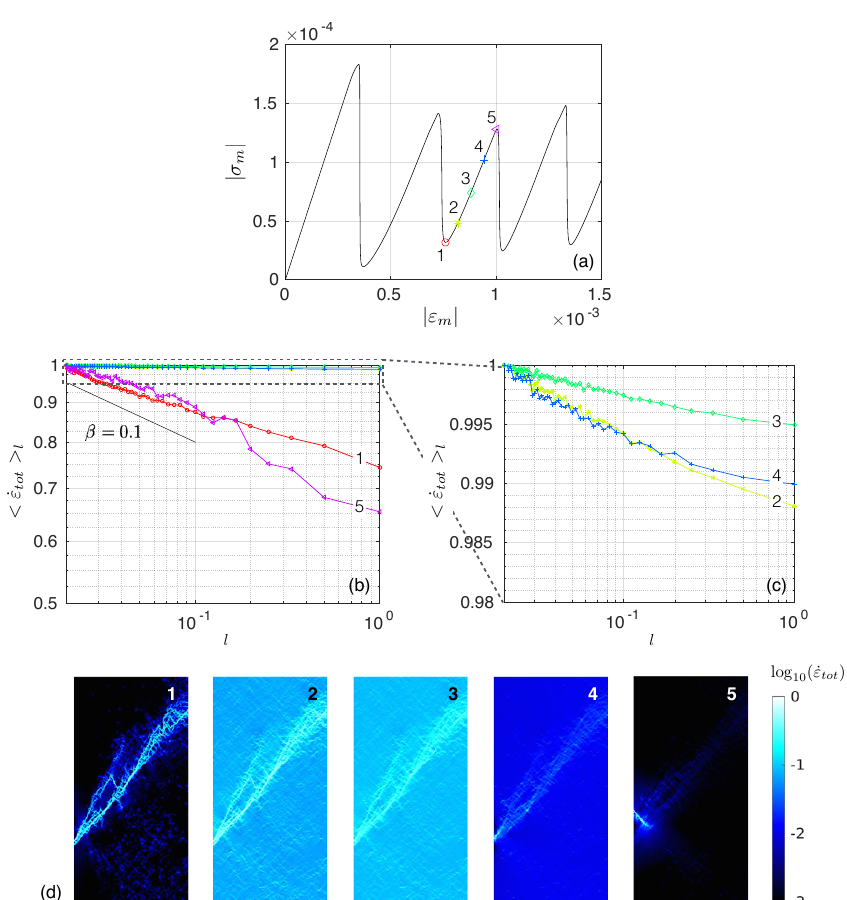
Figure 7. (a) Macroscopic stress as a function of the macroscopic strain for one realization of the uniaxial compression experiment with N = 100. (b) Total deformation rate as a function of the spatial scale ( l = L with 1 ≤ n ≤ N/ 2), normalized at the smallest scale L/N , 2 n at the five stages indicated on (a) . (c) Zoom into panel (b) for the second, third and fourth stages. (d) Corresponding fields of the order of magnitude of the total deformation rate (log 10 ( ˙ ε tot ) ) normalized by the maximum value of ˙ ε tot .